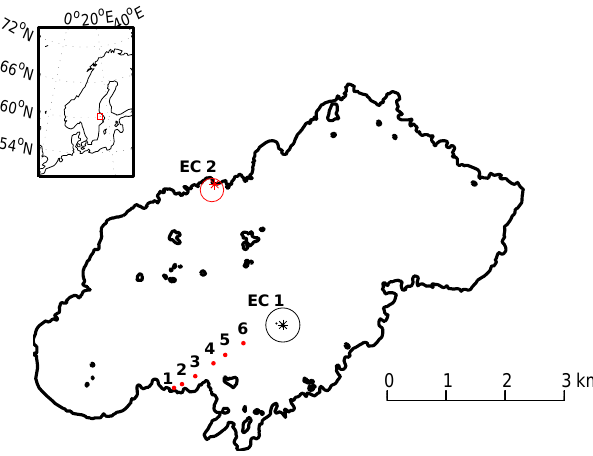
Figure 1. Map of Lake Tämnaren. Upper left inset map marks the position of the lake (red box). The two EC towers denoted with EC1, positioned on the Rättarharet Island and EC2, positioned on the northwest shore (marked with black and red stars). The black and red circles around EC1 and EC2 represent approximate posi- tions of FCs placed in the footprint of the towers. The red dots, numbered 1–6, represent the positions of the chambers used in the